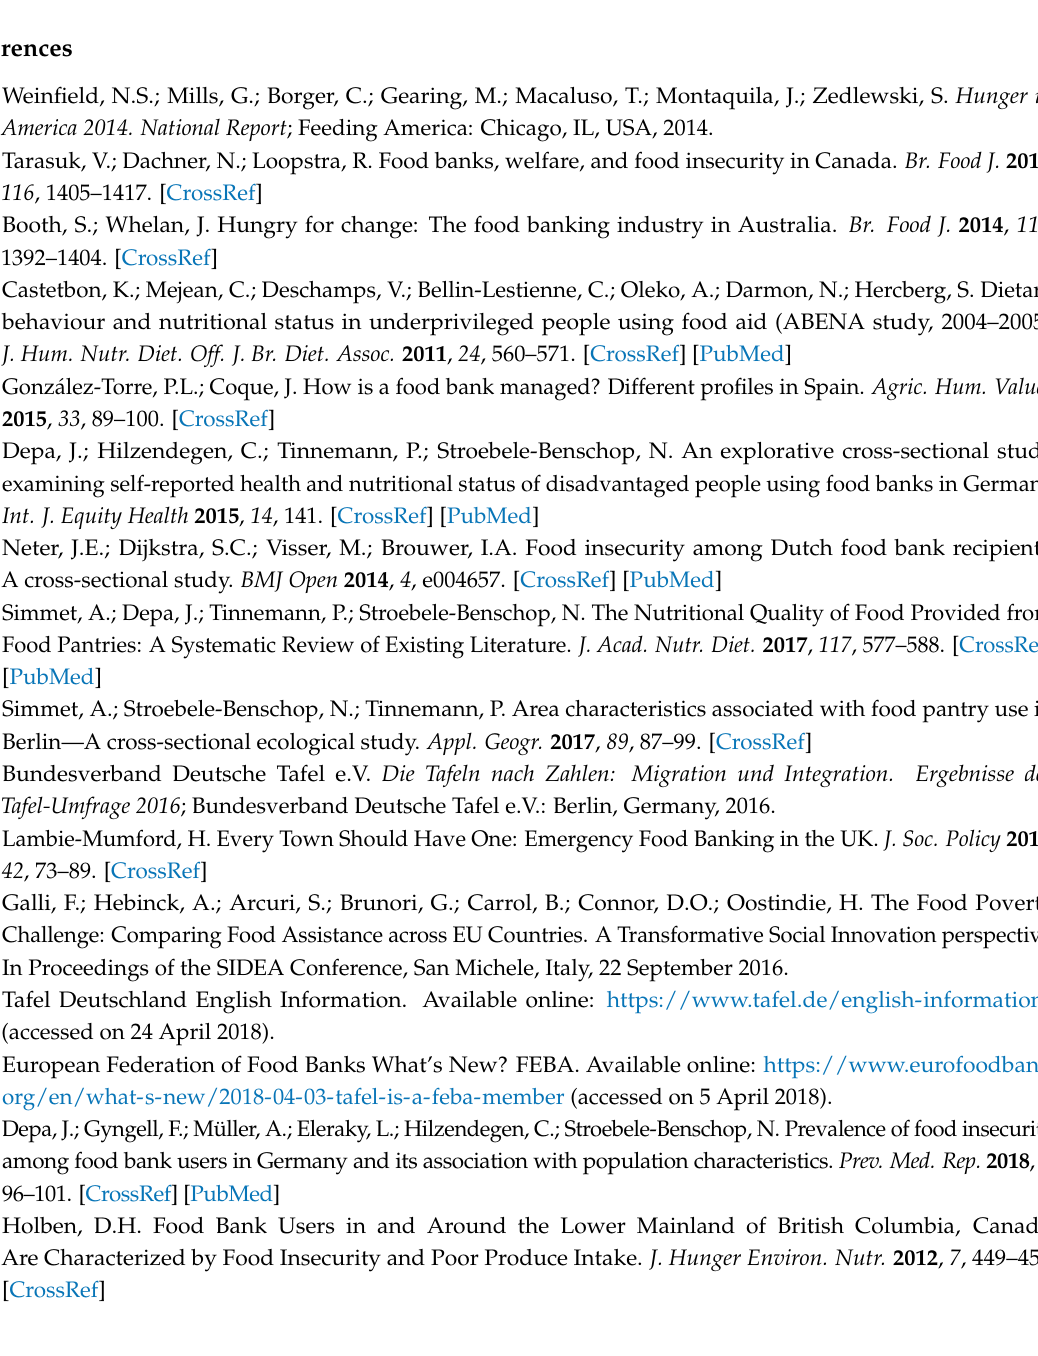
s1, Table S1: Questionnaire content, developed for a representative survey among German food banks: questions, answer options, variables